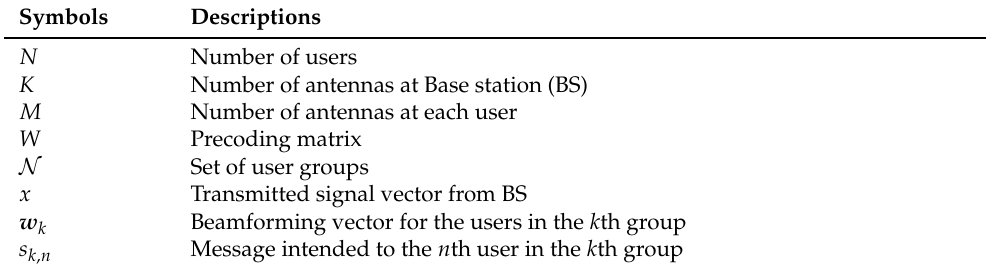
Table 1. Symbols and